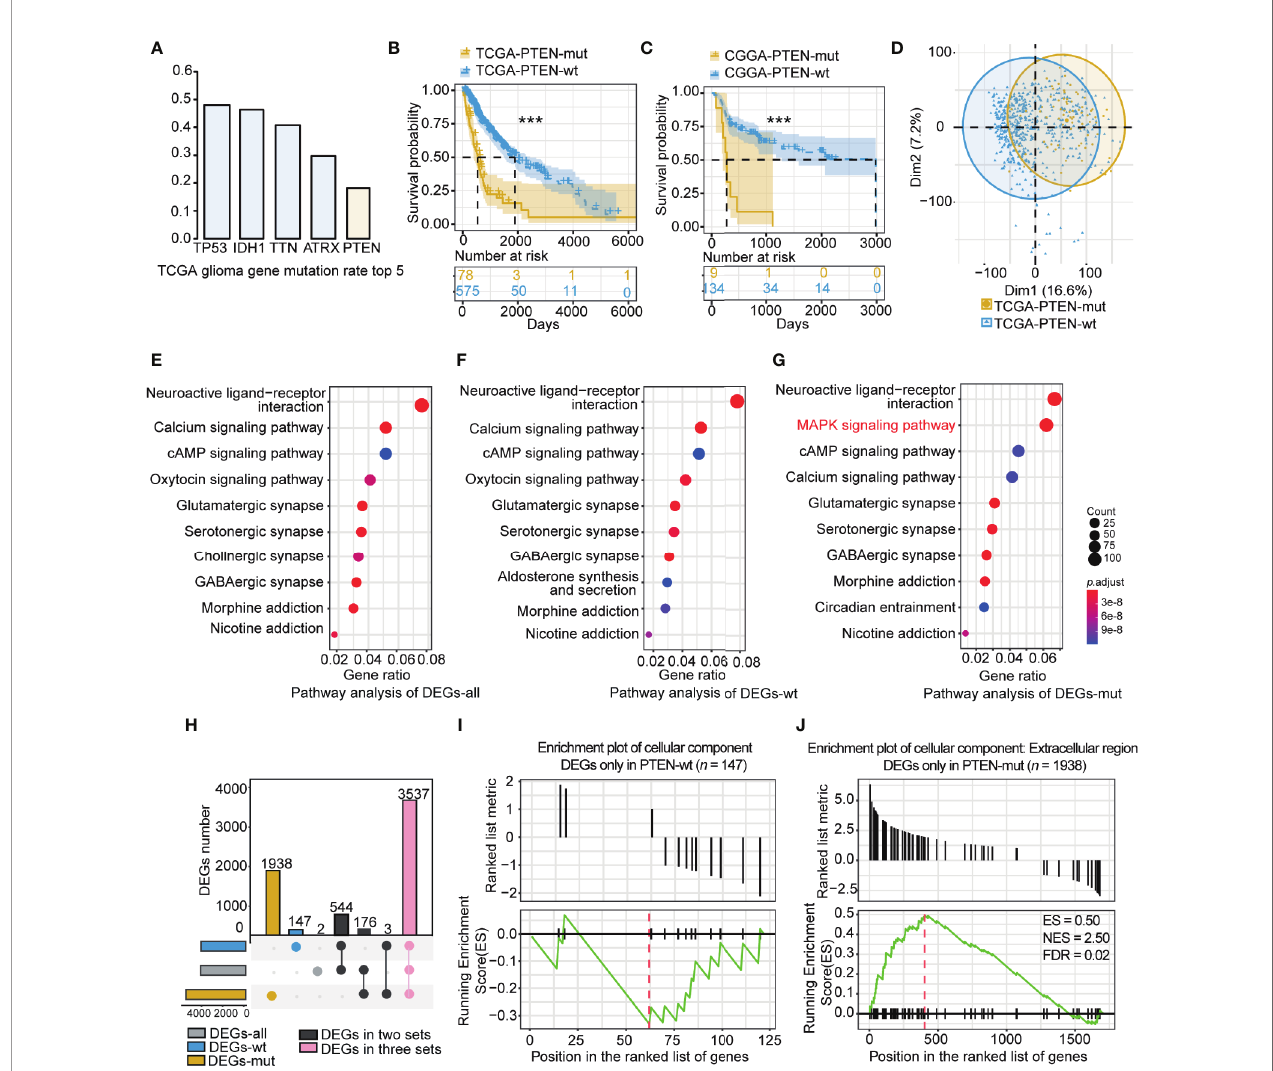
FIGURE 2 | The characteristic of PTEN-wt and PTEN-mut subgroup: (A) The top 5 gene mutation rate in TCGA glioma; (B) Survival analysis (Kaplan Meier Curve) of PTEN-wt (blue, n = 575) and PTEN-wt subgroup (yellow, n = 78) in TCGA dataset; (C) Survival analysis (Kaplan Meier Curve) of PTEN-wt (blue, n = 134) and PTEN- wt subgroup (yellow, n = 9) in CGGA dataset; (D) The principal component analysis of TCGA PTEN-wt (blue, n = 575) and TCGA PTEN-mut subgroup (yellow, n = 78 ); (E) Pathway analysis of DEGs-all (DEGs from TCGA glioma vs. normal tissue, 653 vs 5); (F) Pathway analysis of DEGs-wt (DEGs from TCGA PTEN-wt glioma vs. normal tissue, 575 vs 5); (G) Pathway analysis of DEGs-mut (DEGs from TCGA PTEN-mut glioma vs. normal tissue, 78 vs 5); (H) The overlap of DEGs-all, DEGs- wt, and DEGs-mut; (I) The GESA enrichment plot of cellular component for DEGs only in PTEN-wt ( n = 147); (J) The GESA enrichment plot of cellular component for DEGs only in PTEN-mut ( n =1938). DEGs-all: DEGs from TCGA glioma vs. normal tissue ; DEGs-wt: DEGs from TCGA PTEN-wt glioma vs. normal tissue; DEGs- mut: DEGs from TCGA PTEN-mut glioma vs. normal tissue. *** p <